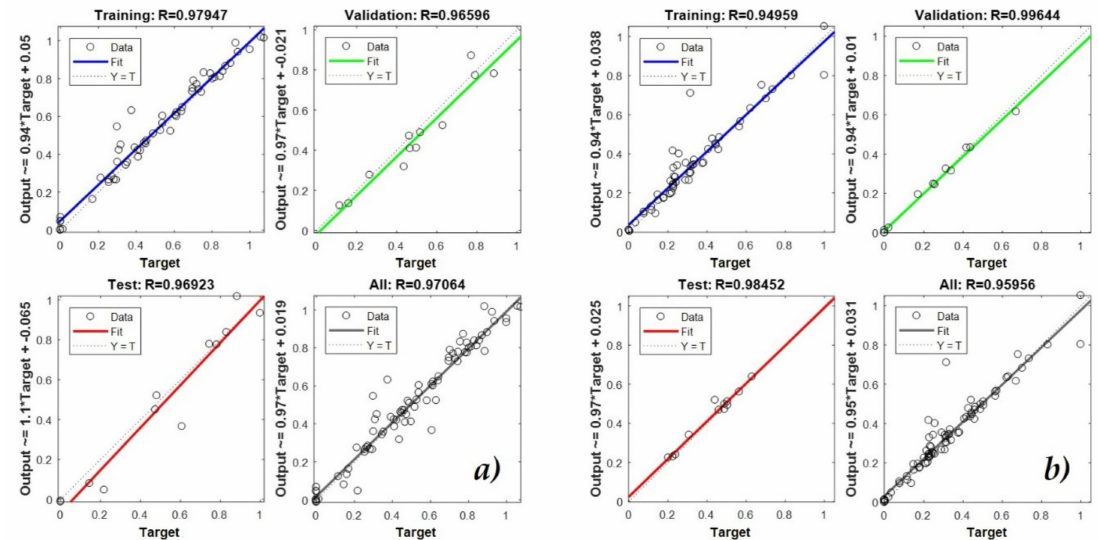
Figure 2. Training, validation, and test processes for the ANNs of the ( a ) substrate, and ( b )